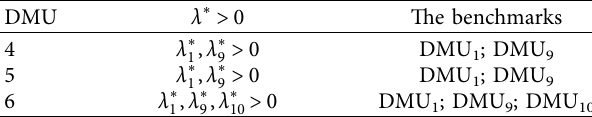
Table 5: The benchmarks obtained for inefficient DMUs.